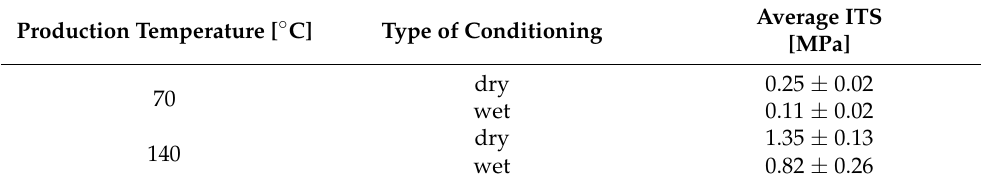
Table 2. ITS values of 100% RAP mixes produced at 70 and 140 ◦ C after dry/wet conditioning. Production Temperature [ ◦